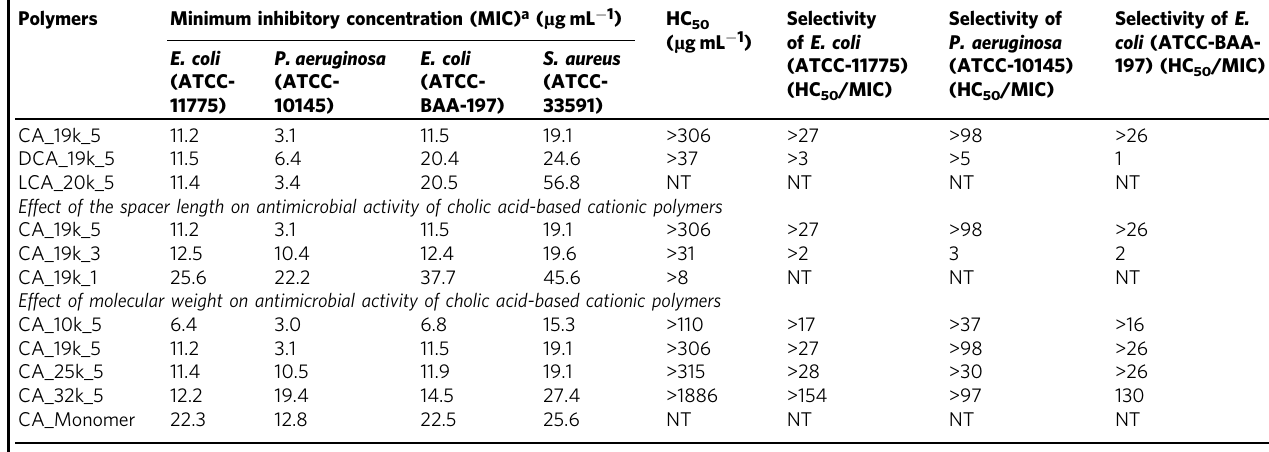
Table 1 Antimicrobial activity of different multicyclic natural product-based cationic polymers by a broth microdilution method Polymers Minimum inhibitory concentration (MIC) a ( µ g mL − 1